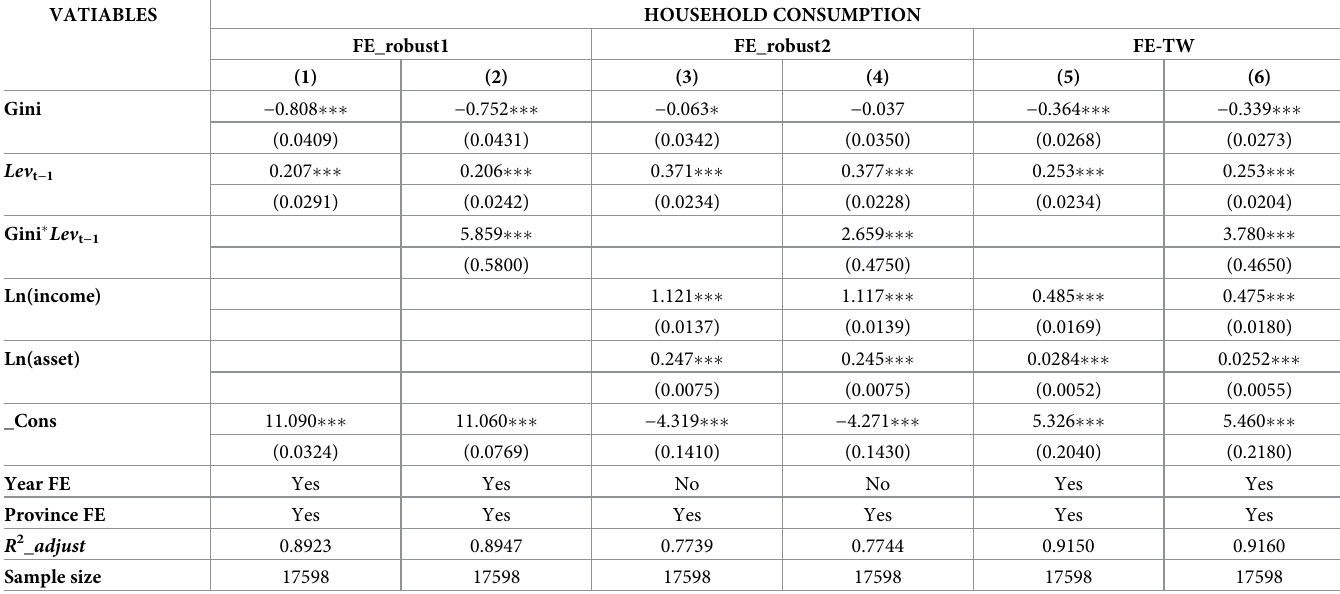
Table 3. Income inequality and household debt on total household consumption.